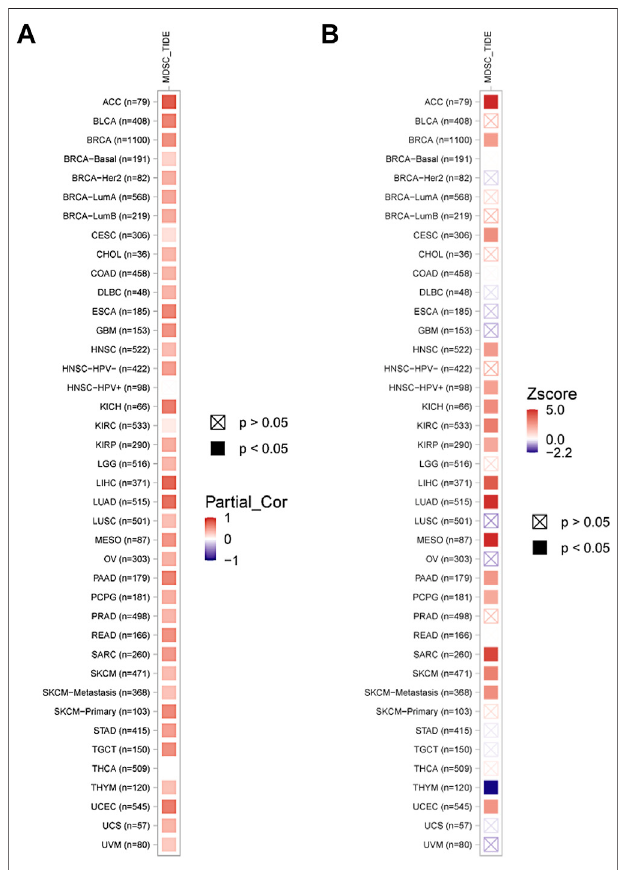
FIGURE7|(A) CorrelationofKIF2CwithMDSCsinpan-cancer. (B) The prognosis analysis of MDSCs, red means poor prognosis, blue means good